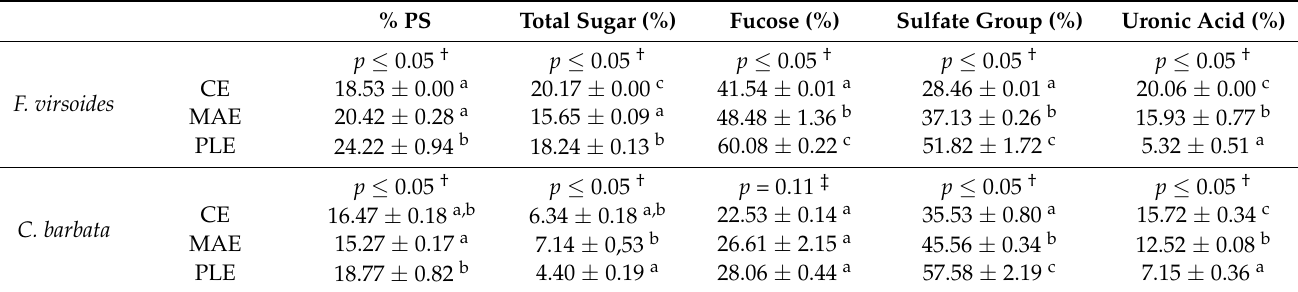
Table 4. Yield (% PS) and chemical composition of CE (conventional), MAE (microwave) and PLE (pressurised liquid) extracted polysaccharides from Fucus virsoides and Cystoseira barbata . % PS Total Sugar (%) Fucose (%) Sulfate Group (%) Uronic Acid